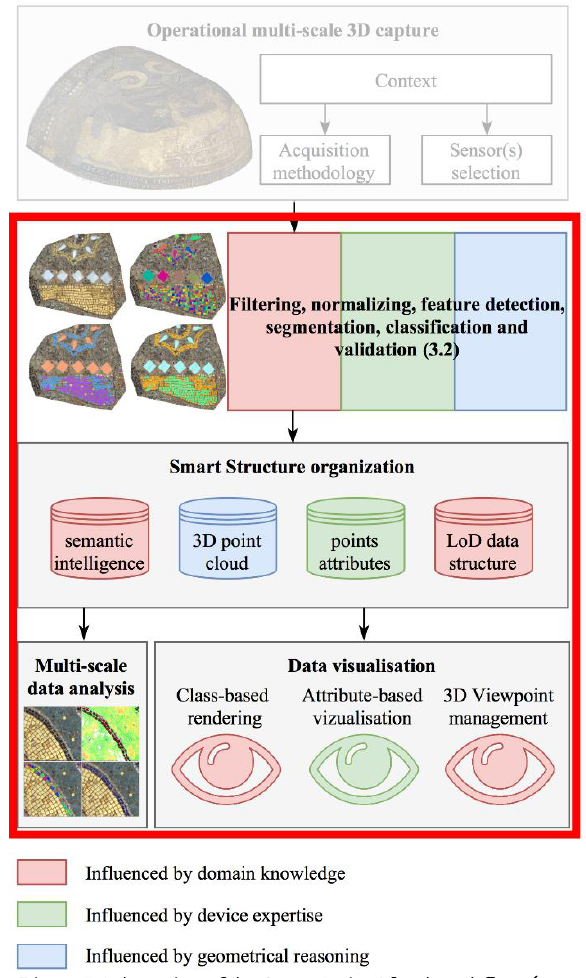
Figure 5 Adaptation of the Smart Point Cloud workflow (Poux